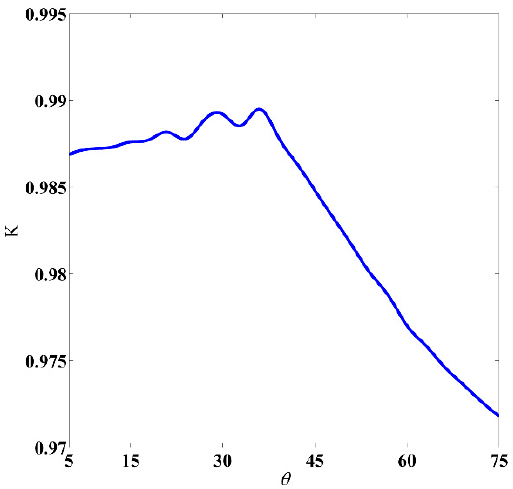
Figure 9. The TE-TE-TE polarization mode is used for three-beam interference, and the contrast at different incident angles is obtained when the polarization direction of the three beams has a deviation of ±5°.